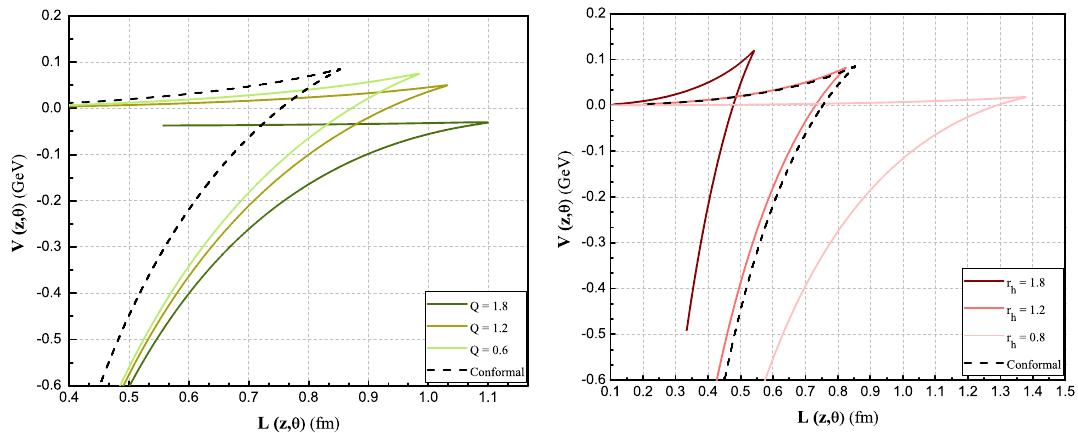
Fig. 2 Left: the heavy quark potential versus the quark-antiquark separation in different Q at θ = d − 1 and z = 2. Right: the heavy quark potential versus the quark-antiquark separation in different r h at θ = d − 1, z = 2 and Q =